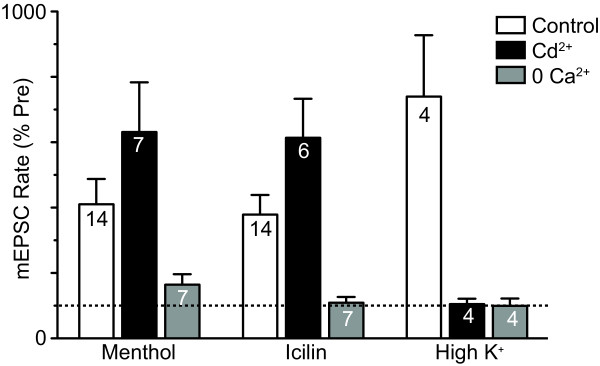
Menthol and icilin enhancement of glutamatergic transmission is independent of voltage dependent calcium channels. Bar chart showing the change in miniature EPSC (mEPSC) rate produced by menthol (400 μM), icilin (100 μM) and elevated external K+ (25 mM), in normal ACSF (control), in ACSF containing Cd2+ (30 μM), and in Ca2+-free ACSF (0 Ca2+). Data are expressed as a percentage of the pre-menthol, icilin and high K+ levels, and averaged across all neurons. The number in the bars represent the total number of neurons tested under each condition.